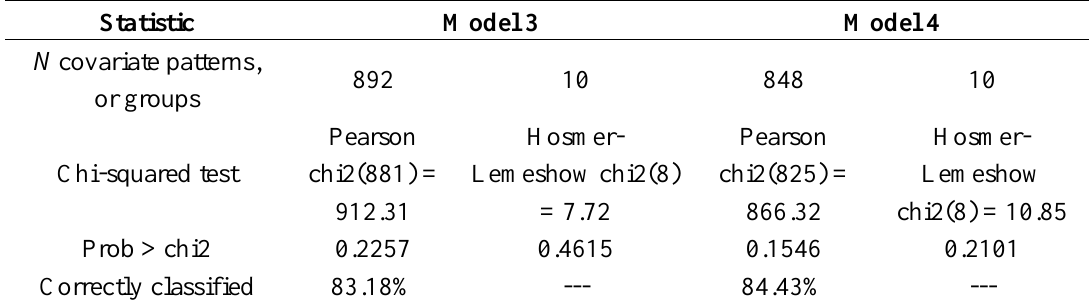
Table A2. Diagnostics for Regressions on Local Seafood Scenario (see Table